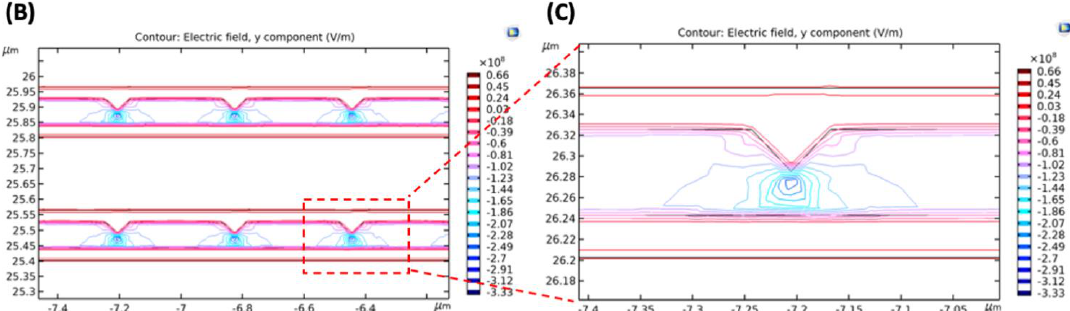
Figure 2. ( A ) Fluidic resistance model for the cell trapping process. The first cell is trapped when there is less flow resistance. After the cell is trapped, the fluidic resistance across this short path is increased, and the cells inside the fluid follow the bypass path. ( B ) FEM-based simulation of saw-tooth shaped electrodes for studying the electric field for maximum fusion efficiencies. ( C ) Zoomed-in view of the simulated electric field near the electrode tip. The cells are attracted to the tip of triangular electrodes for positive-DEP (pDEP).